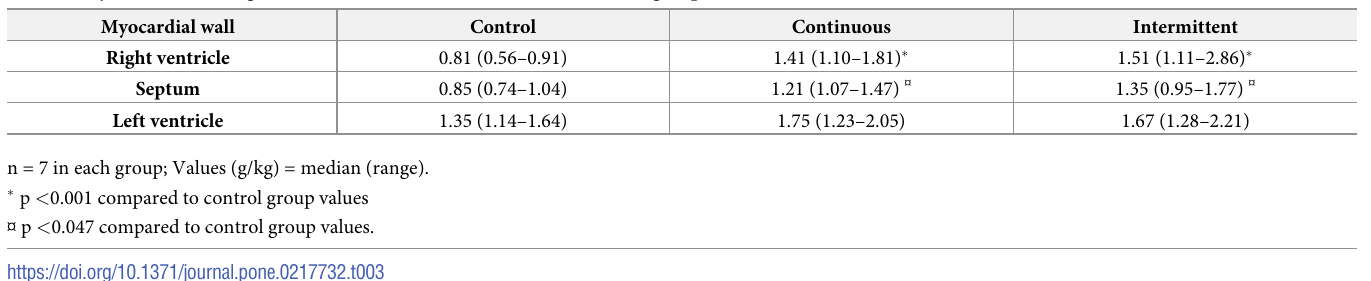
Table 3. Myocardial wall weights in the control, continuous, and intermittent